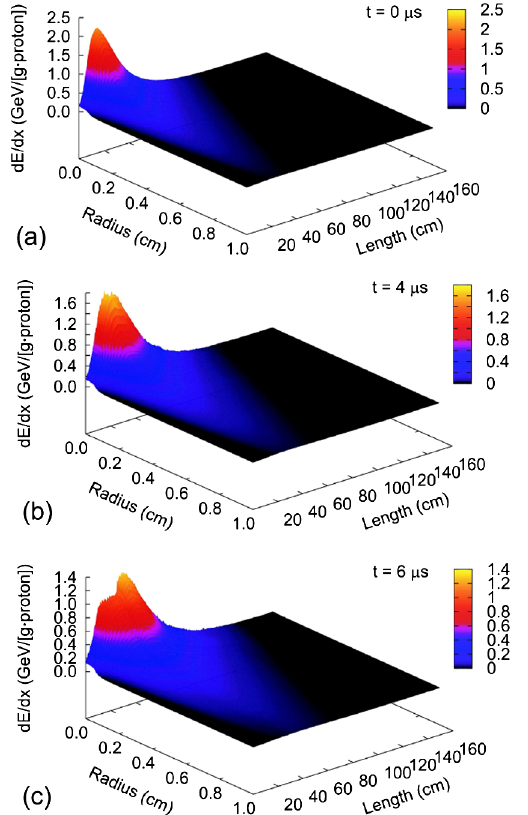
FIG. 10. FLUKA calculations of energy deposition of a single 440 GeV SPS proton in a solid copper cylinder having radius r ¼ 5 cm , length L ¼ 1 : 5 m , with facial irradiation, beam spot size characterized by standard deviation (cid:1) ¼ 0 : 5 mm ; (a) using solid density of 8 : 93 g = cm 3 ; (b) using the density distribution provided by the BIG2 at t ¼ 4 (cid:2) s (fourth iteration); and (c) using the density distribution provided by the BIG2 at t ¼ 6 (cid:2) s (sixth